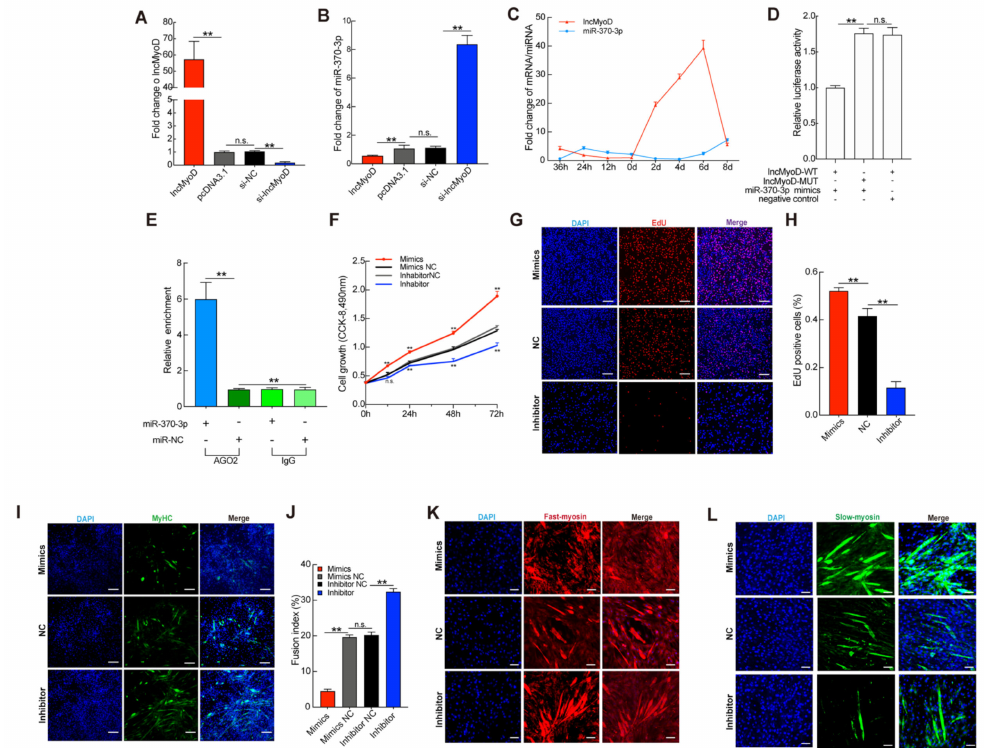
Figure 4. lncMyoD direct targeting miR-370-3p to mediate skeletal myofiber composition. When C2C12 myoblast differ- entiation was induced by differentiation medium (DM), the cells were transfected with miR-370-3p mimics, mimics NC, miR-370-3p inhibitor and inhibitor NC. ( A , B ) The expression of lncMyoD and miR-370-3p when C2C12 were transfected with lncMyoD, pcDNA3.1, si-lncMyoD, si-NC in DM at 8 days. ( C ) qRT-PCR measured the expression levels of lncMyoD and miR-370-3p during C2C12 proliferation and differentiation. ( D ) Luciferase assays revealed the suppressive effect of miR-370-3p on the activity of lncMyoD. ( E ) LncMyoD relative expression was determined by being pulled down with anti-AGO2. After C2C12 myoblasts in GM were transfected with synthesized miR-370-3p mimics, mimics NC, miR-370-3p inhibitor and inhibitor NC, CCK-8 assay ( F ) and EdU proliferation assay ( G , H ) at 24 h of transfection was evaluated. ( J – L ) After transfection for 8 d of C2C12 myoblast differentiation the immunofluorescence was used to analyze MyHC ( I ), fusion index of myotube ( J ). Differentiated C2C12 myotubes were transfected with miR-370-3p mimics, mimics NC, miR-370-3p inhibitor and inhibitor NC for 8 d, and immunofluorescence was used to analyze myosin-fast–positive ( K ) myosin-slow–positive ( L ). Scale bars in ( G ) 100 µ m and in ( I , K , L ) 50 µ m. Data are means ± SD. p -values are obtained from independent-samples t -tests. ** p < 0.01, n.s. no